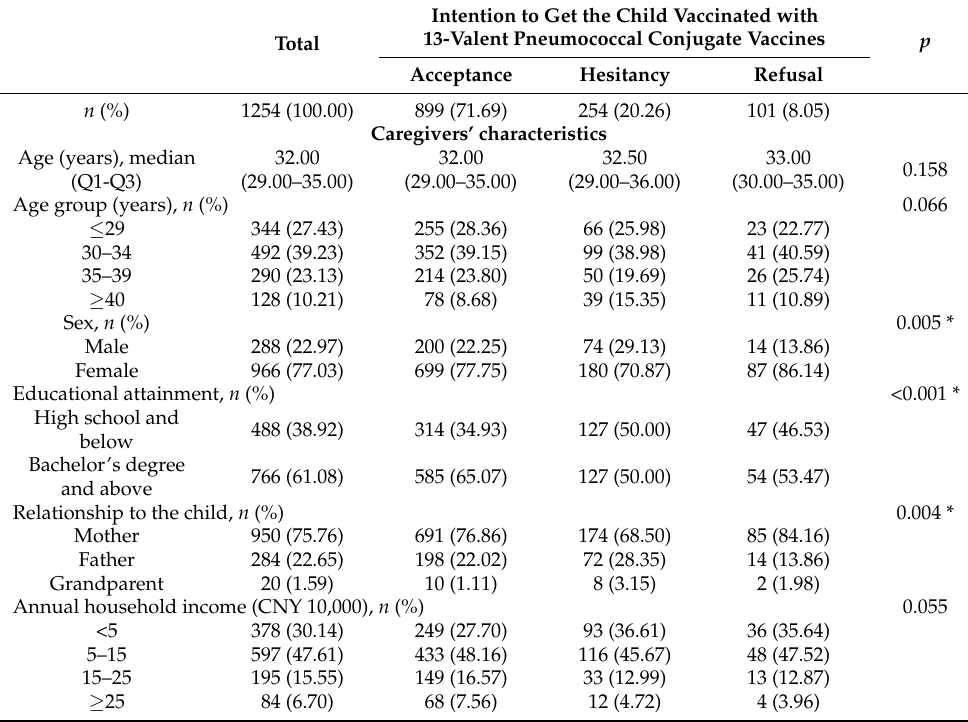
Table 1. Demographics of caregivers and their